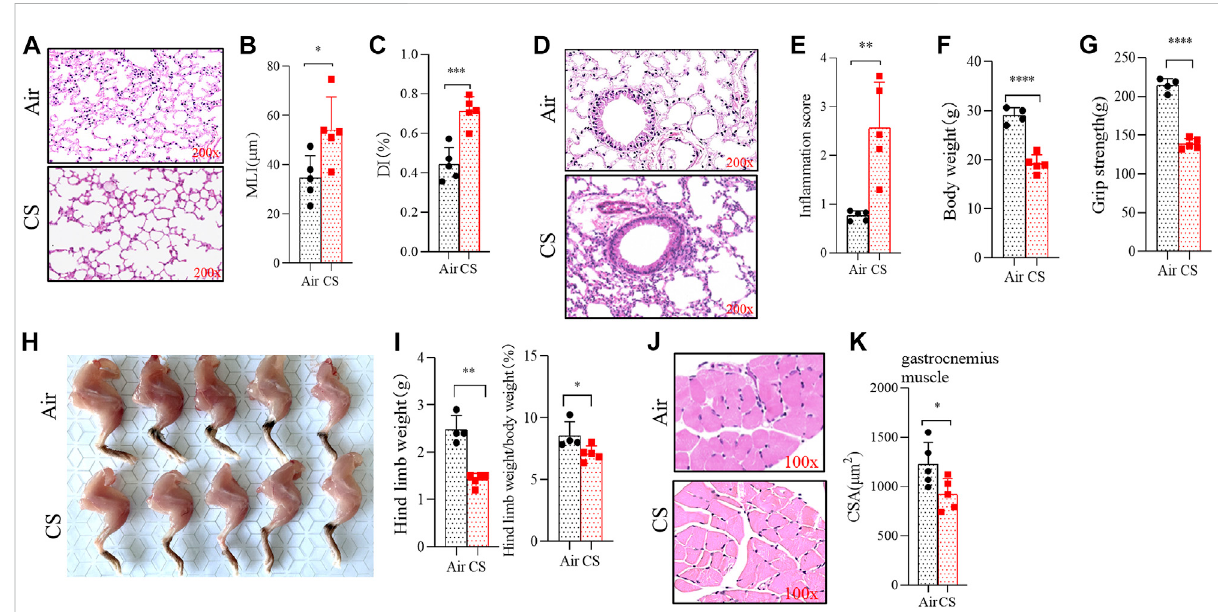
FIGURE 1 Long-term cigarette smoke (CS) exposure led to skeletal muscles dysfunction. (A,D) hematoxylin – eosin (H&E) staining of lung tissues from miceexposedtoairandCS. (B,C) histogramofmeanlinearinterceptanddestructiveindex. (E – G) histogramofin fl ammationscore,bodyweight,and grip strength. (H) anatomic morphology of hind limbs. (I) statistical results of hind limbs weight (left) and hind limbs weight/body weight (right). (J) H&E staining of the gastrocnemius muscle. (K) statistical results of the mean cross-sectional area of gastrocnemius muscle fi bers. n = 5, * p